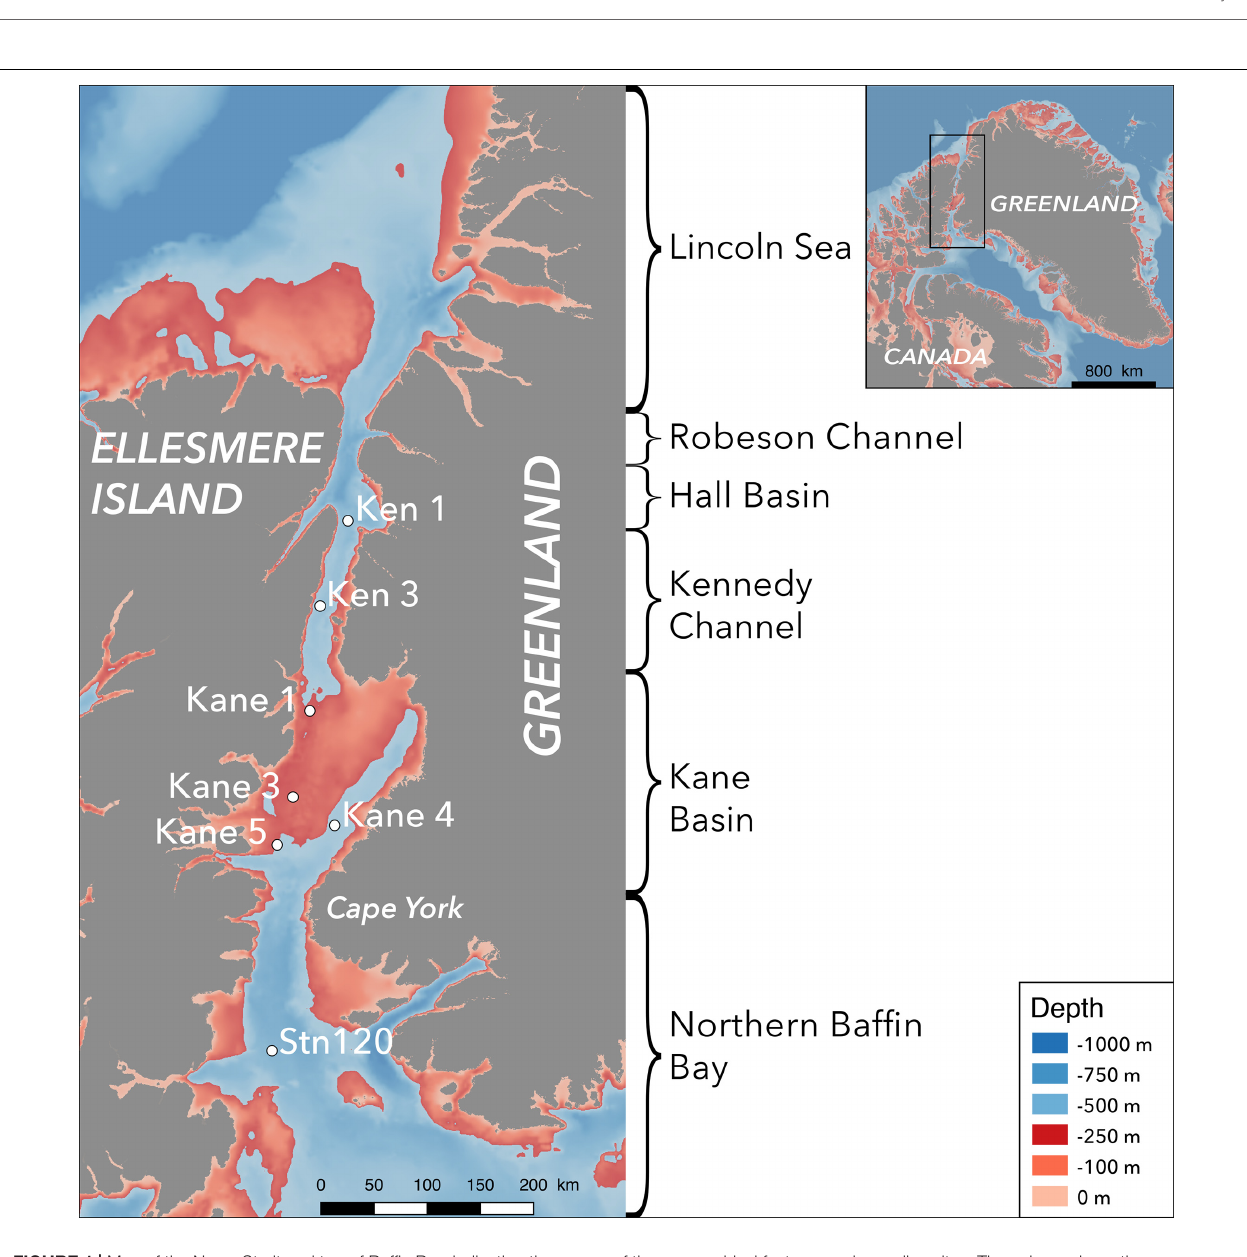
south where all samples were collected. (Canadian Ice Service archive data 1